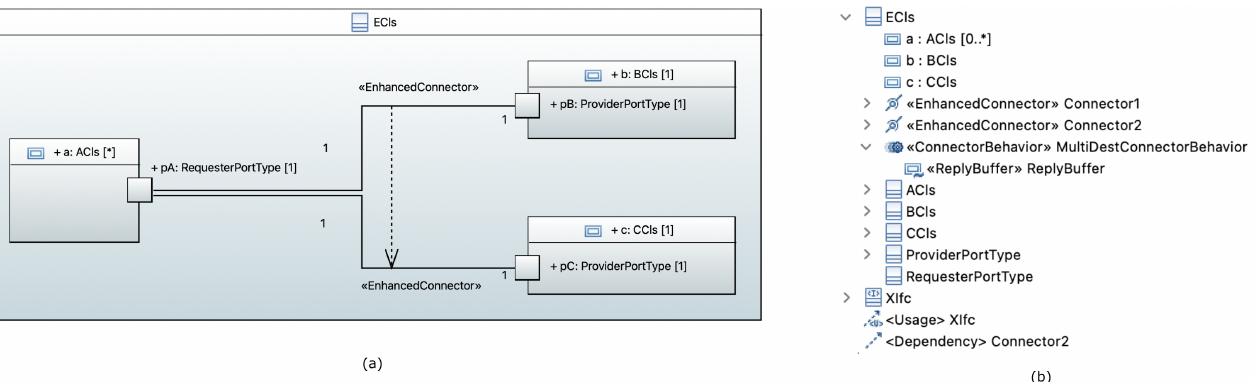
Figure 7. The Quicksort algorithm using ALF and graphical notation.